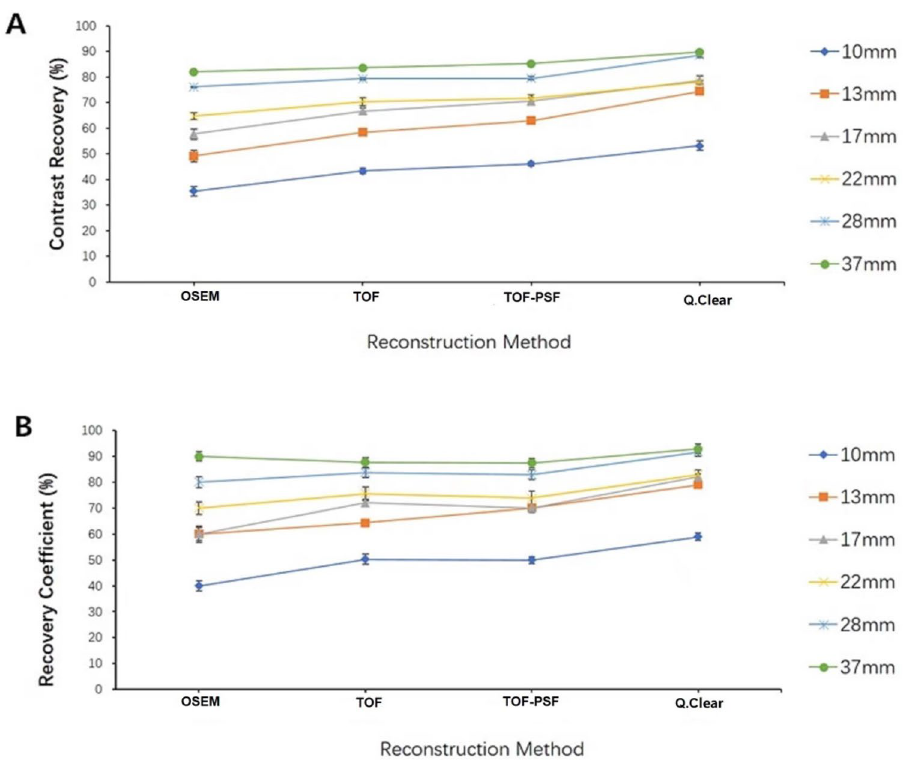
Figure 2. Comparison of recovery coefficient ( A ) and contrast recovery ( B ) among PET reconstruction methods for 6 hot spheres (diameter 10–37 mm) filled with 13.2 kBq/mL Fluoride ions in a 4-to-1 contrast